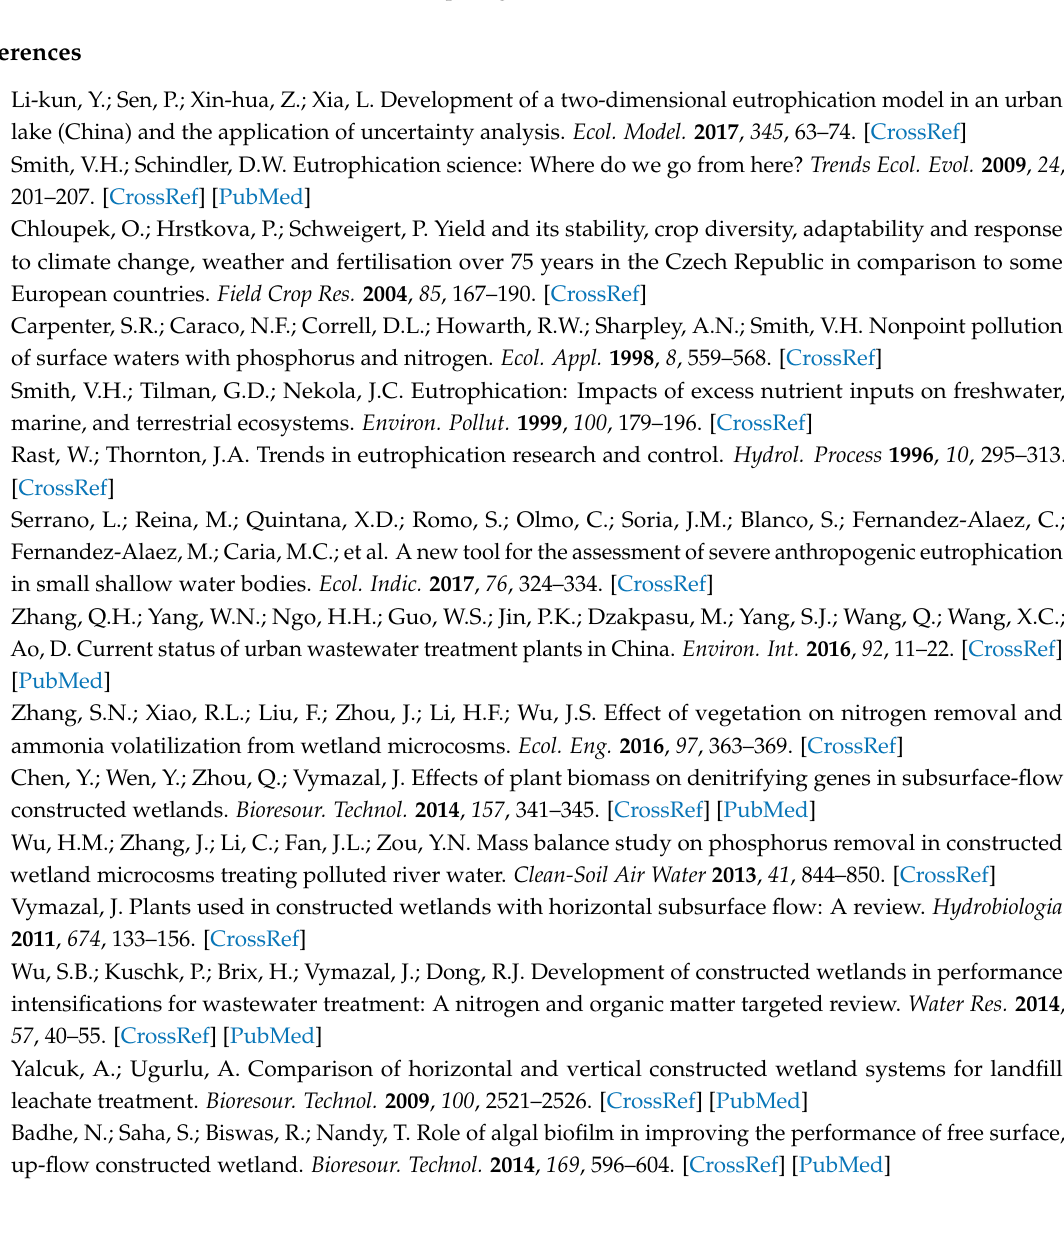
s1, Figure S1: Comparison of theoretical and actual concentrations of COD and NH 4+ in the LSCW and the PSCW. Theoretical concentrations of COD and NH 4+ were predicted through the established Monod model equations for the LSCW and the PSCW. (A) shows the accuracy test of the LSCW model equations for representing the LSCW performance; (B) shows the significant difference between the theoretical prediction of the PSCW performance using the LSCW equations and the actual performance of the PSCW; (C) shows the accuracy test of the PSCW model equations for representing the PSCW performance. Paired t -testing was performed, and the statistical significance is presented as follows: * p < 0.05, ** p < 0.01, *** p < 0.001, and **** p <